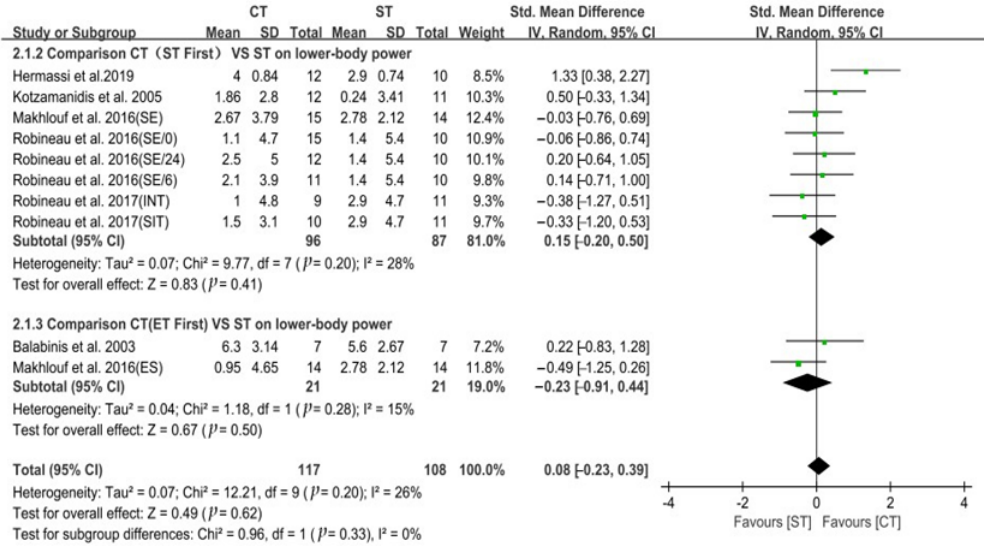
Figure 4. Forest plot comparing the effect of CT versus ST alone on lower-body power [7,9,50,52 – 54].